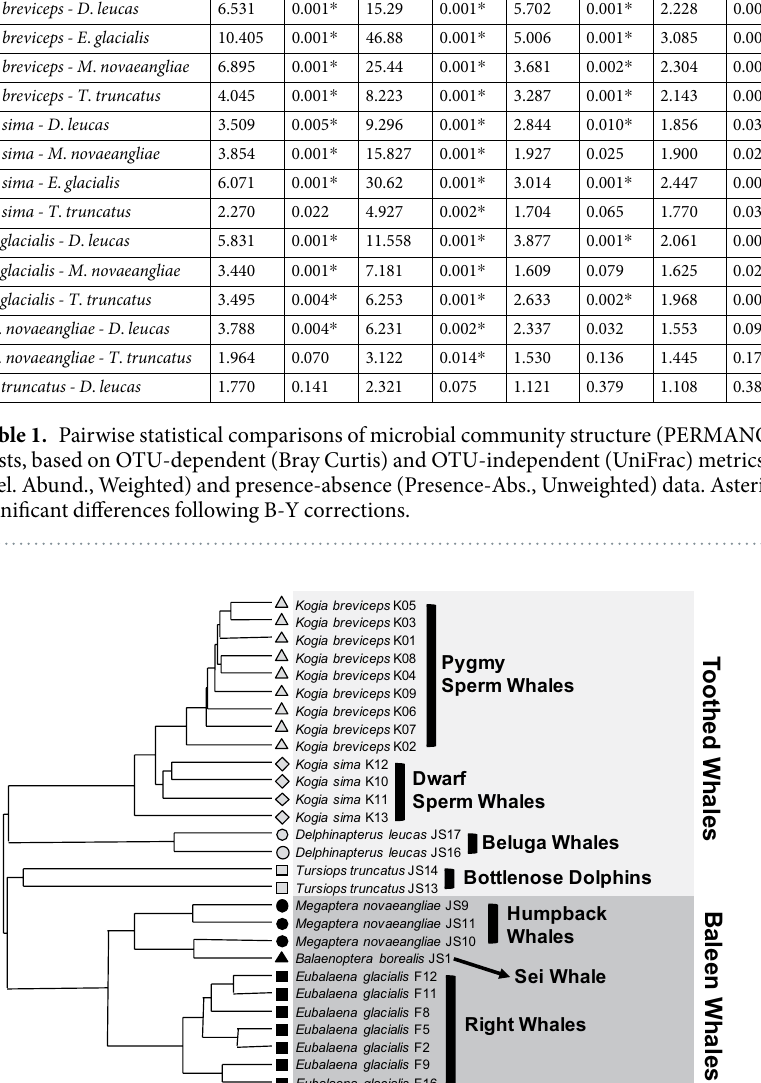
were differentiated by the relative abundance of shared symbiont taxa. As a result, distinct microbial community structure was detected between kogiid species, as well as, among kogiid microbial communities and previously characterized gut microbiomes of other toothed and baleen whales. Notably, these latter differences were driven by differences in community membership and several dominant kogiid-associated OTUs exhibited high levels of differentiation from any described bacteria, indicating the presence of unique symbiont taxa in these hosts. Kogiid gut microbiomes exhibited unique structure and composition and a high-degree of host-specificity, thus highlighting the importance of host identity in structuring cetacean microbiomes. The diversity of gut microbial communities in kogiid whales was unexpectedly high, as previous investiga- tions of toothed whale gut microbiomes revealed low levels of phylum- and OTU-level diversity. Symbiont OTU richness in K . breviceps (432 ± 7) and K . sima (416 ± 18) was nearly five times higher than the gut microbiomes of bottlenose dolphins ( T . truncatus 52 ± 8) and beluga whales ( D . leucas 84 ± 18) included in comparative analyses